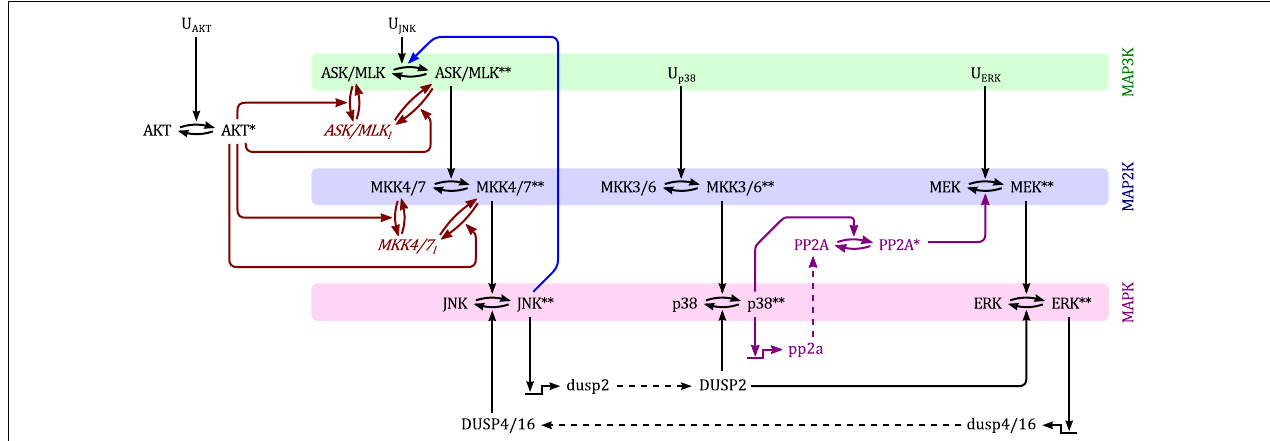
Blue: positive feedback from JNK to its own MAP3Ks; Red: negative crosstalk from AKT to JNK signaling; Purple: negative crosstalk from p38 to ERK signaling only occurring in non-transformed cells. Lower- and upper-case letter indicate mRNAs and proteins, respectively. Single and double asterisk indicate single- and double-phosphorylated active forms,